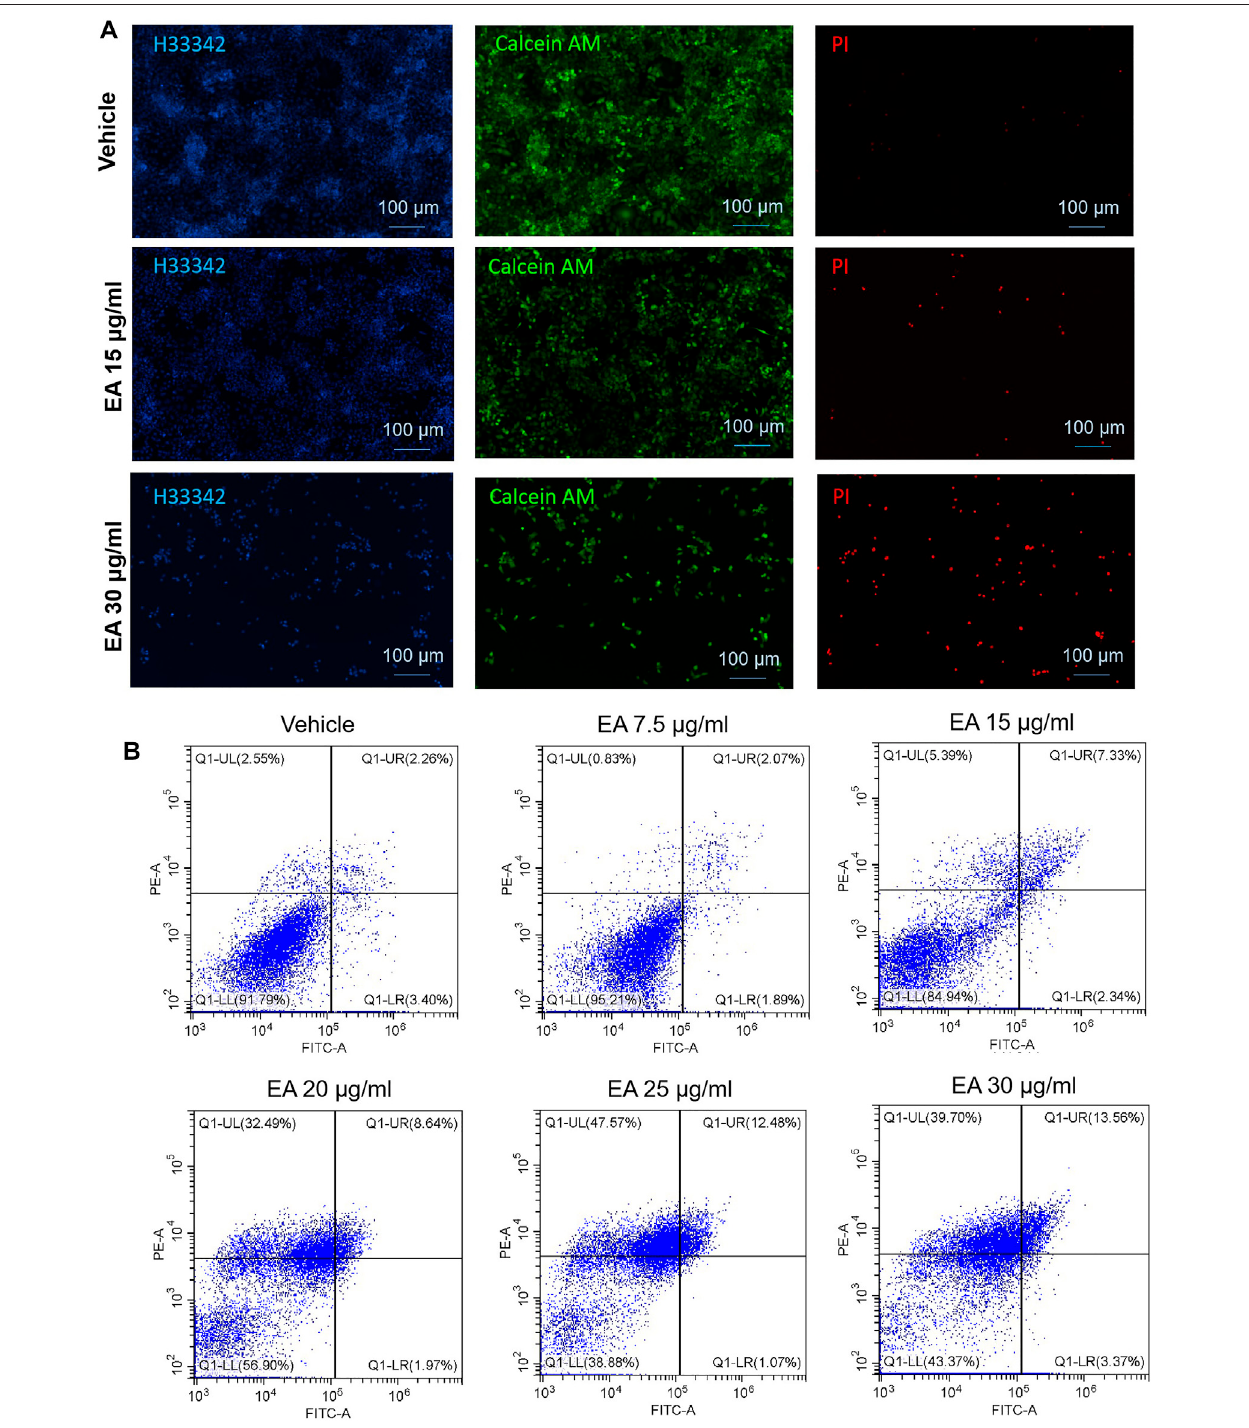
FIGURE 5 | EA induced colorectal cancer cell death via a non-apoptotic manner. (A) Living cells were stained by calcein AM (green fl uorescence), dead cells were stainedbyPI(red fl uorescence),andallthecellnucleiwerestainedbyHoechst33342(blue fl uorescence). (B) PIandAnnexinVdoublestainedcellswereanalyzedby fl ow cytometry. The X -axis showed the FITC intensity representing the Annexin V on the cell outer membrane, and the Y -axis represented the PI staining intensity of cells. In the four quadrants, Q1-LR represented the early apoptotic cells population, and Q1-UR represented the late apoptotic cells population.